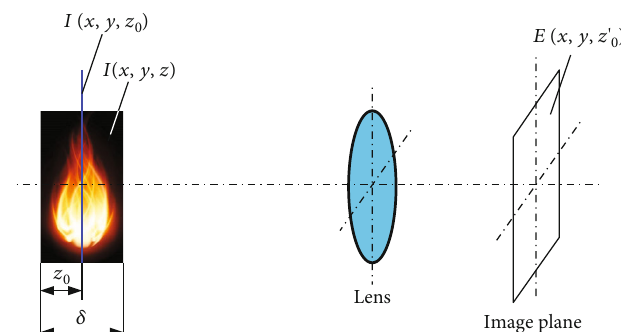
Figure 1: The schematic of conventional